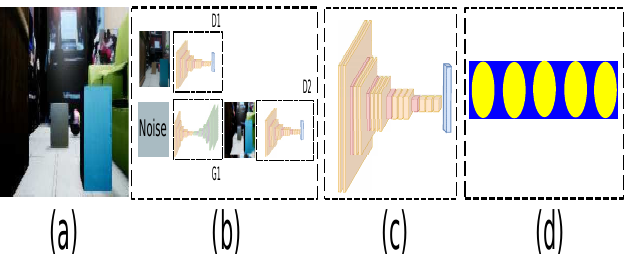
Figure 8. Domain change system. ( a ) Input sample. ( b ) Domain change by a GAN. ( c ) Features extraction network by deep convolutional network. ( d ) Generated path network by recurrent network.